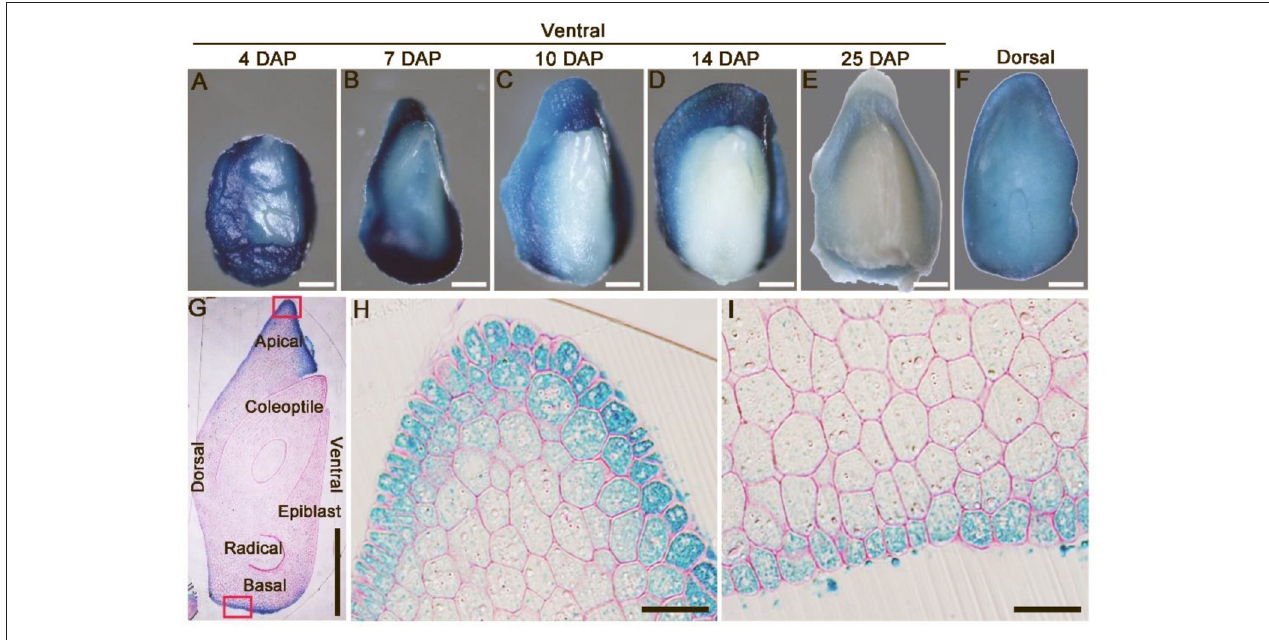
FIGURE 3 | Expression pattern of OsLEC1 . (A–E) Ventral side of pOsLEC1:GUS embryos (4–25 DAP) stained in X-Gluc solution for 3h at 37 ◦ C. Scale bars = 200 µ m. (F) Dorsal side of pOsLEC1:GUS embryos (14 DAP) stained in X-Gluc solution for 3h at 37 ◦ C. Scale bars = 200 µ m. (G) Longitudinal resin section of embryos (7 DAP) of pOsLEC1:GUS embryo stained in X-Gluc solution overnight at 37 ◦ C. Scale bars = 200 µ m. (H,I) Amplification of the regions in black boxes in G, showing the apical (H) and basal (I) parts of the scutella parenchyma, respectively. Scale bars = 50 µ